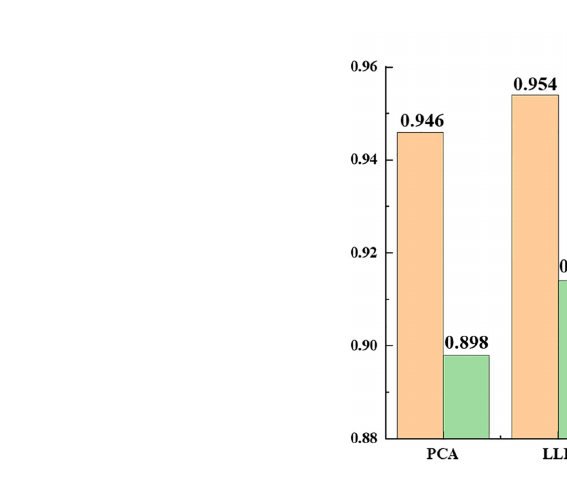
FIGURE 11 Comparison of recognition results of different spectral